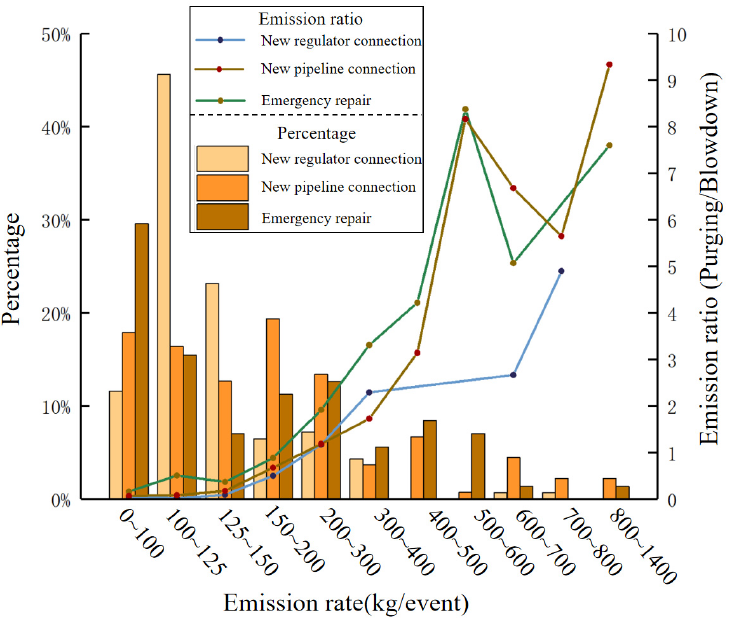
Figure 9. Distribution of methane emission rate from